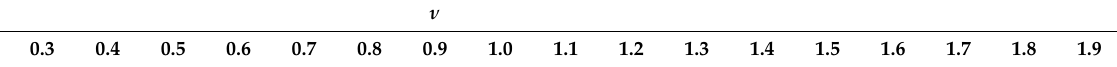
Table 5. Correlation matrix for FSGD: learning rate = 0.001, momentum = 0.9 and ν =